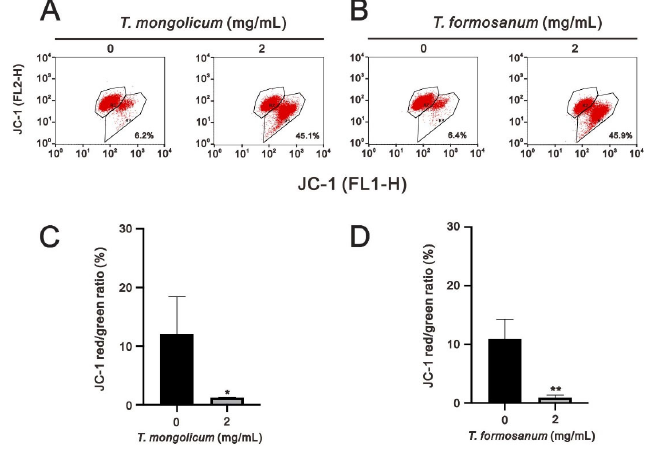
Figure 7. Effects of T. mongolicum and T. formosanum on mitochondrial membrane potential in MDA ‐ MB ‐ 231 cells. MDA ‐ MB ‐ 231 cells were treated with 2 mg/mL of ( A ) T. mongolicum or ( B ) T. for ‐ mosanum for 24 h. Mitochondrial depolarization was measured as a function of a decrease in the red/green (FL2 ‐ H/FL1 ‐ H) fluorescence intensity ratio. ( C , D ) are the results of three independent ex ‐ periments. Symbols and bars depict the mean ±SD. * p < 0.05, ** p < 0.01. We then analyzed the effects of T. mongolicum on mitochondrial respiration, glycoly ‐ sis, and ATP production in MDA ‐ MB ‐ 231 cells based on measurements of the oxygen con ‐ sumption rate (OCR) and extracellular acidification rate (ECAR) using a Seahorse XF an ‐ alyzer. Our results show that T. mongolicum dose ‐ dependently decreased the OCR but not the ECAR (Figure 8A,B), which suggests its primary effect is on mitochondrial respiration, not glycolysis. At a concentration of 2 mg/mL, T. mongolicum significantly decreased basal respiration, maximal respiration, non ‐ mitochondrial respiration, proton leakage, and ATP production (Figure 8C,D, p = 0.001, 0.022, 0.031, 0.022, and 0.002, comparing 2 mg/mL T. mongolicum with vehicle alone). Correspondingly, 2 mg/mL T. mongolicum also decreased OCR/ECAR ratios during basal respiration; however, it did not during maximal respira ‐ tion (Figure 8E, p = 0.031, comparing 2 mg/mL T. mongolicum with vehicle alone).